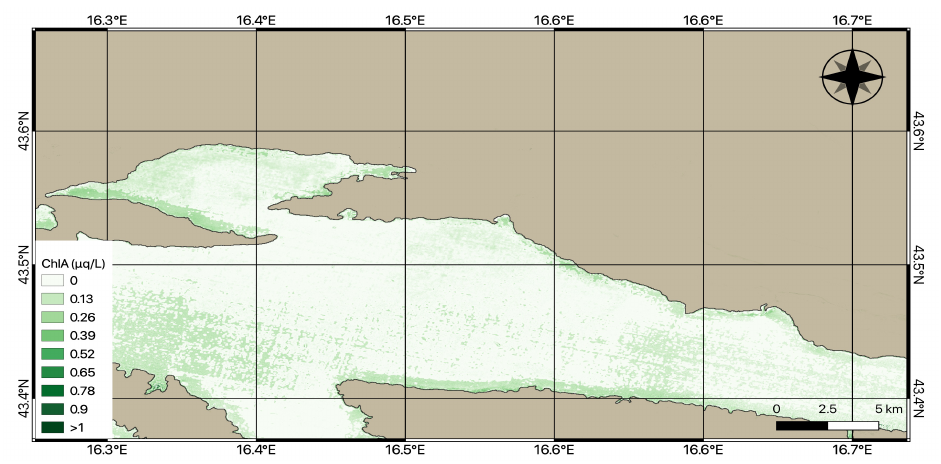
Figure 7. Map of the predicted Chlorophyll-a and its distribution over the Kaštela Bay and the Braˇc Channel on 30 September